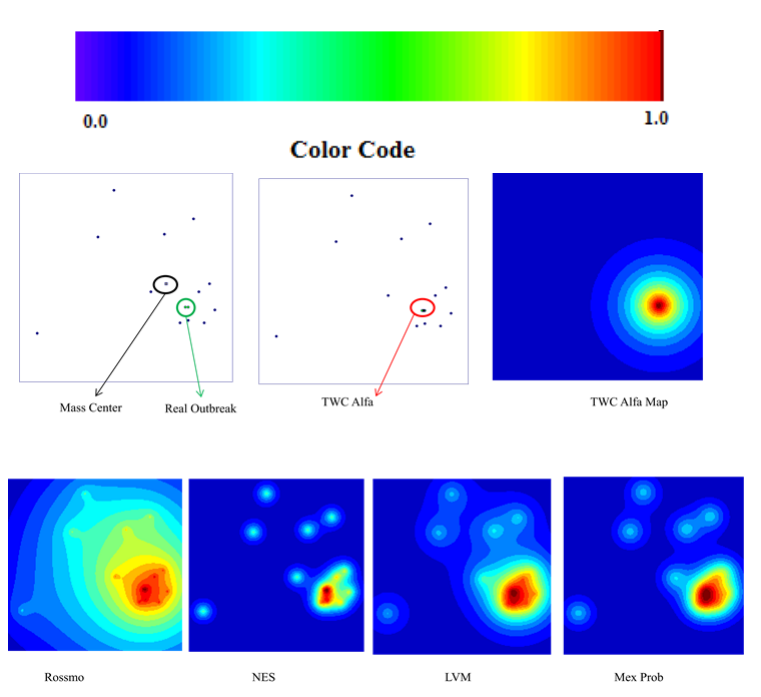
Figure E1. The Chikungunya fever epidemic of